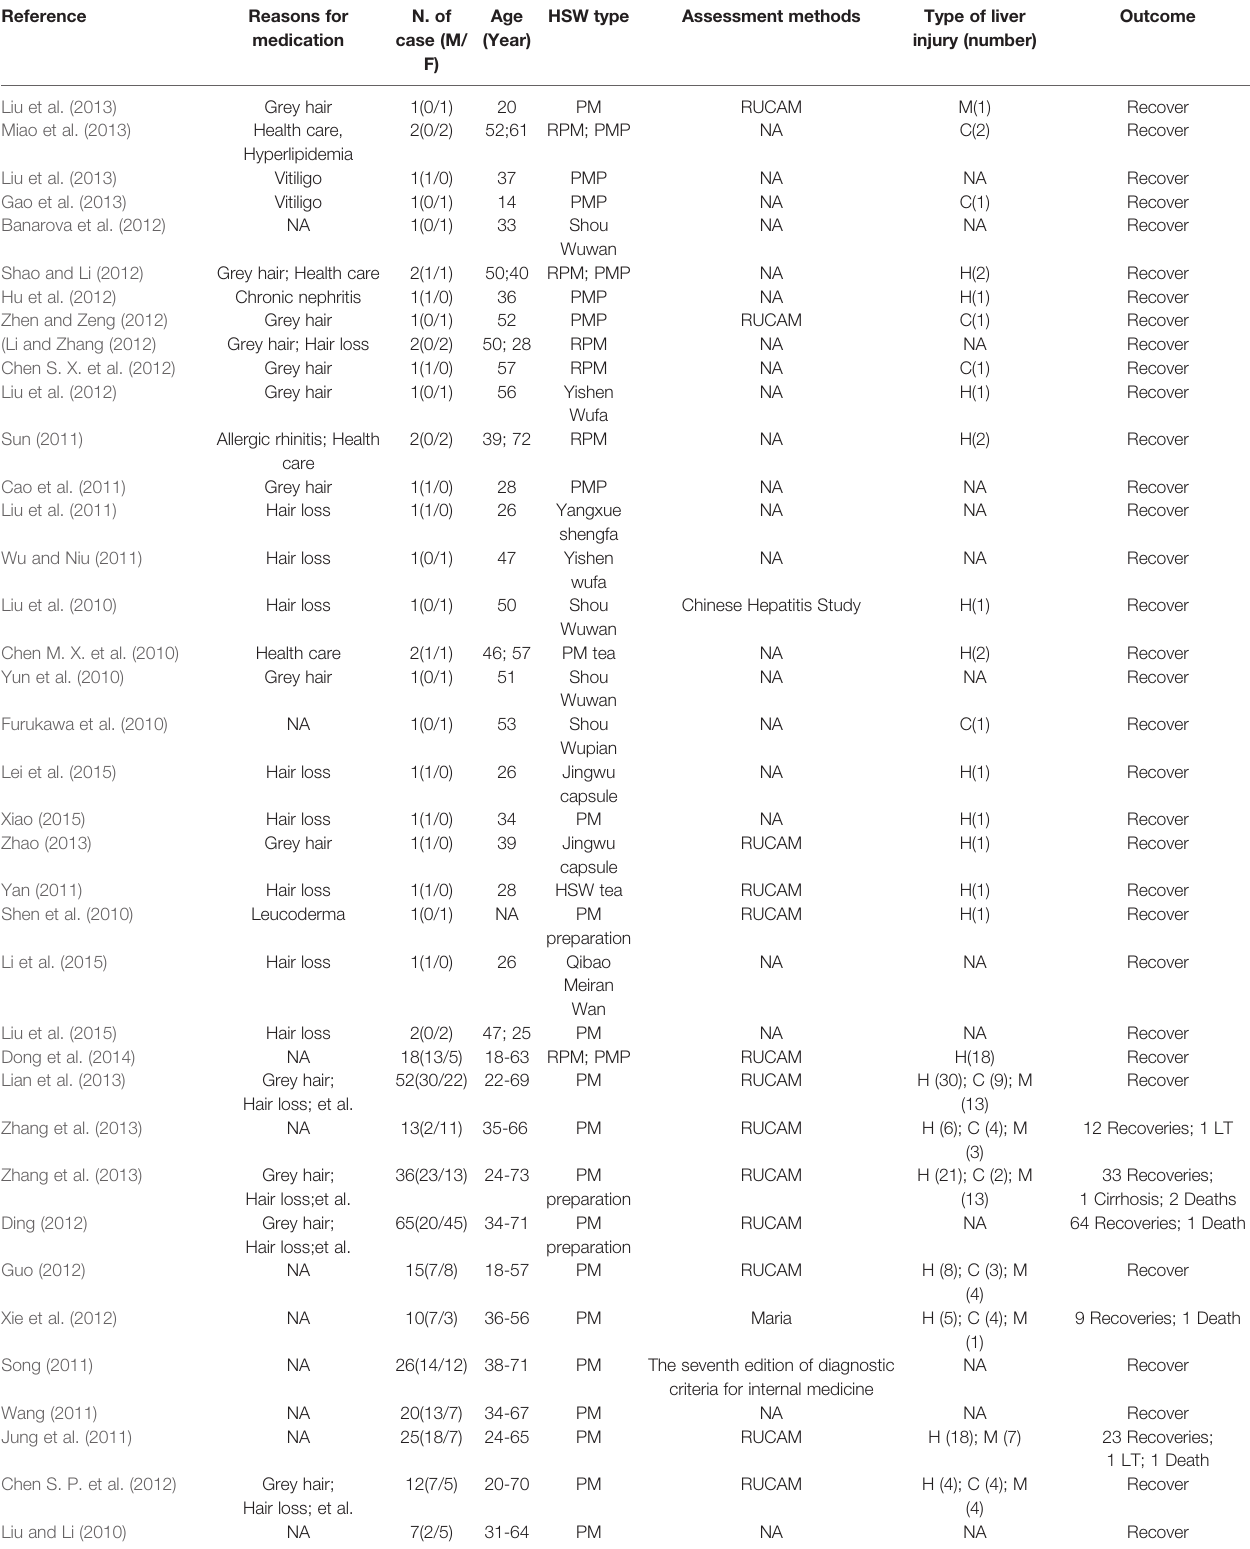
TABLE 1 | Patient details recorded from published case reports and case series on liver injury caused by